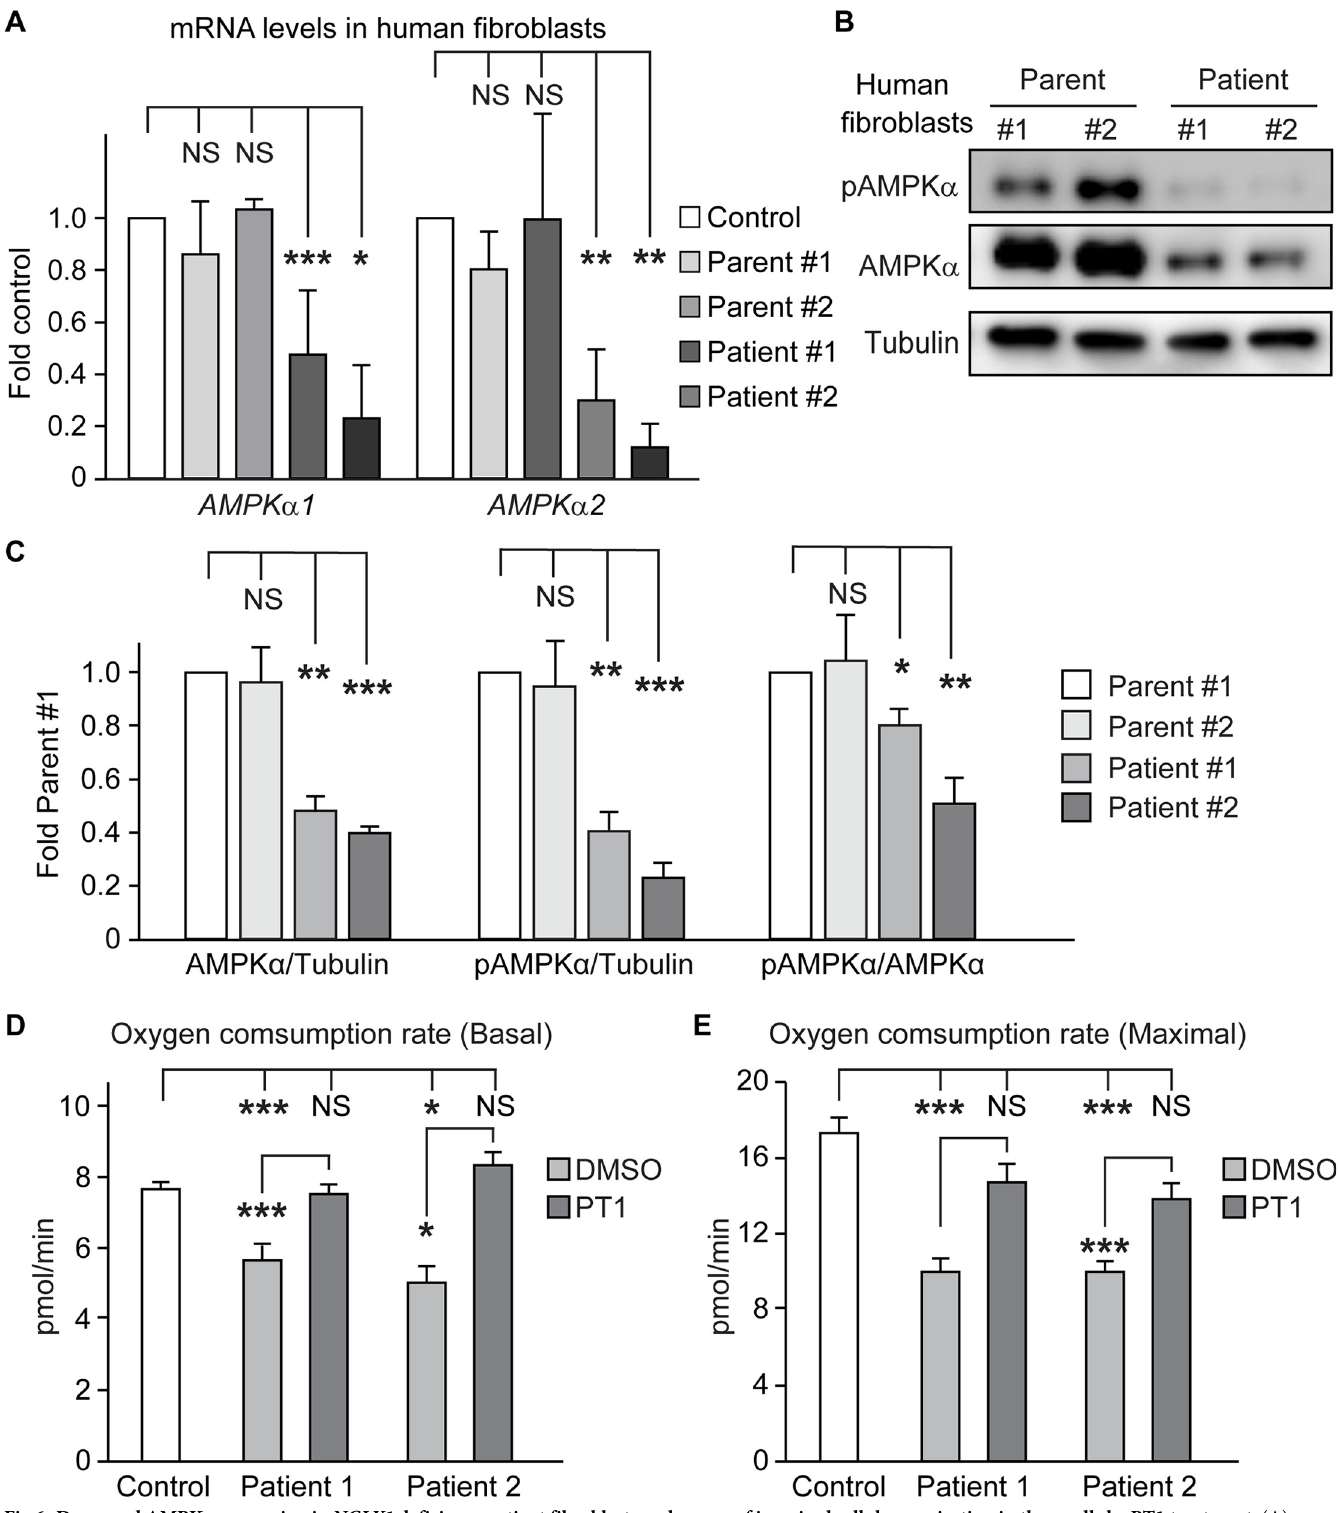
Fig 6. Decreased AMPK α expression in NGLY1 deficiency patient fibroblasts and rescue of impaired cellular respiration in these cells by PT1 treatment. (A) qRT-PCR assays show a significant decrease in the mRNA levels of AMPK α 1 and AMPK α 2 in two different NGLY1 deficiency patient fibroblasts compared to control ( NGLY1 +/+ ) and two different parents ( NGLY1 +/– ) fibroblasts. (B) Western blots show a severe reduction in AMPK α and pAMPK α protein levels in two different